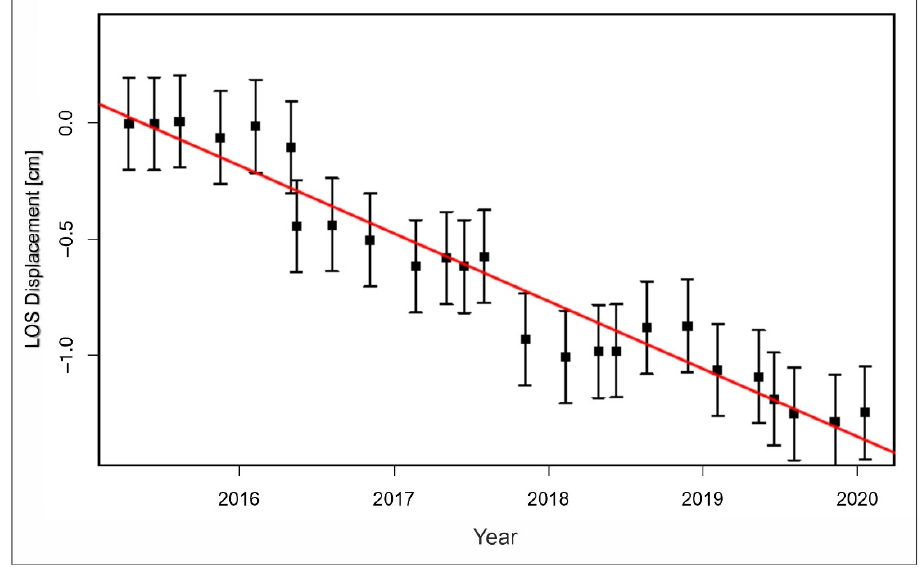
Figure 14. Time series of LOS displacement in the Chgega landslide.